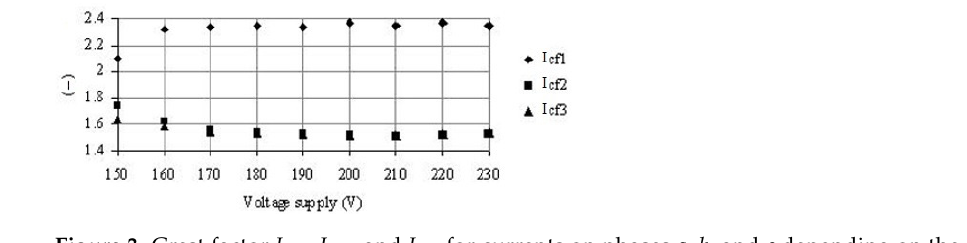
Figure 3. Crest factor I cf1 , I cf2 , and I cf3 for currents on phases a, b, and c depending on the supply voltages (set 1).